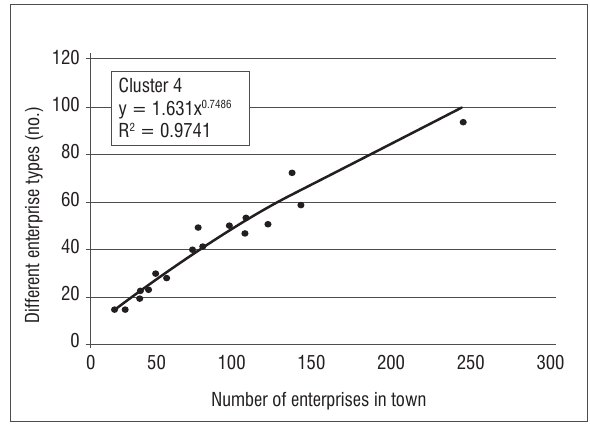
Enterprise richness as a function of the total enterprise numbers of Cluster 4 towns, illustrating the closeness of fit of cluster data.